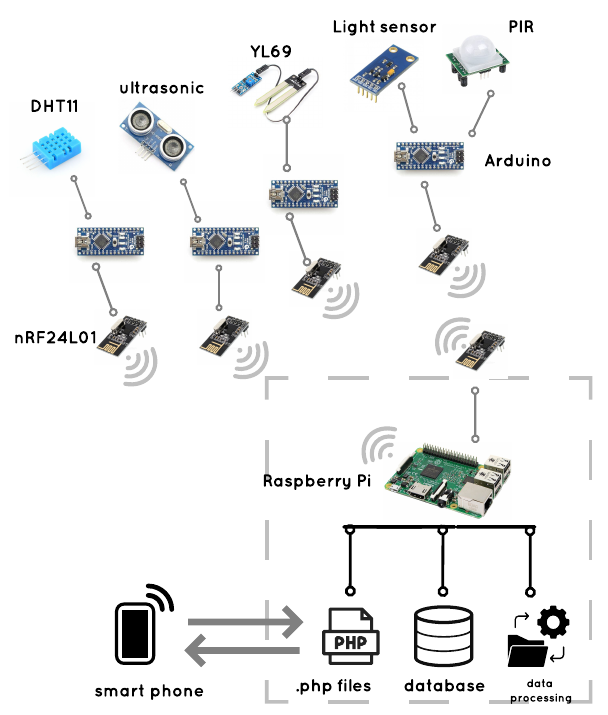
Figure 3. The communication between the components and